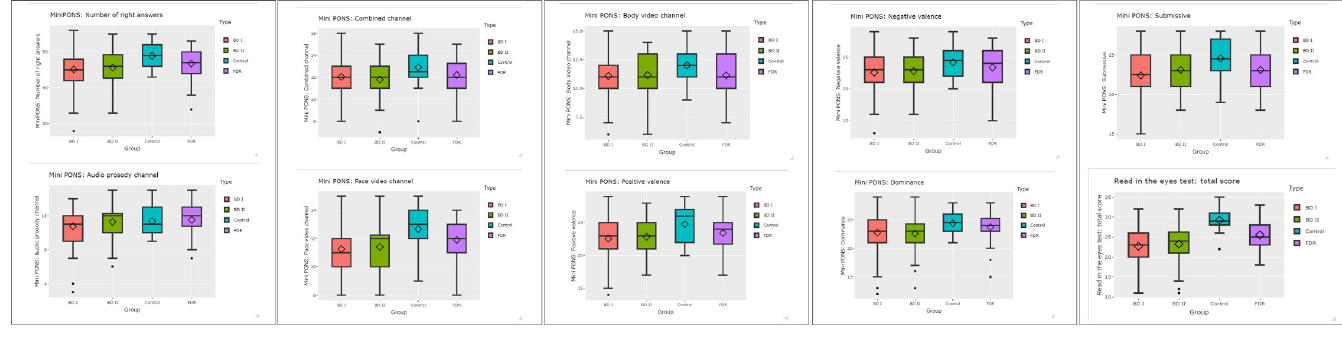
Fig 1. Differences between